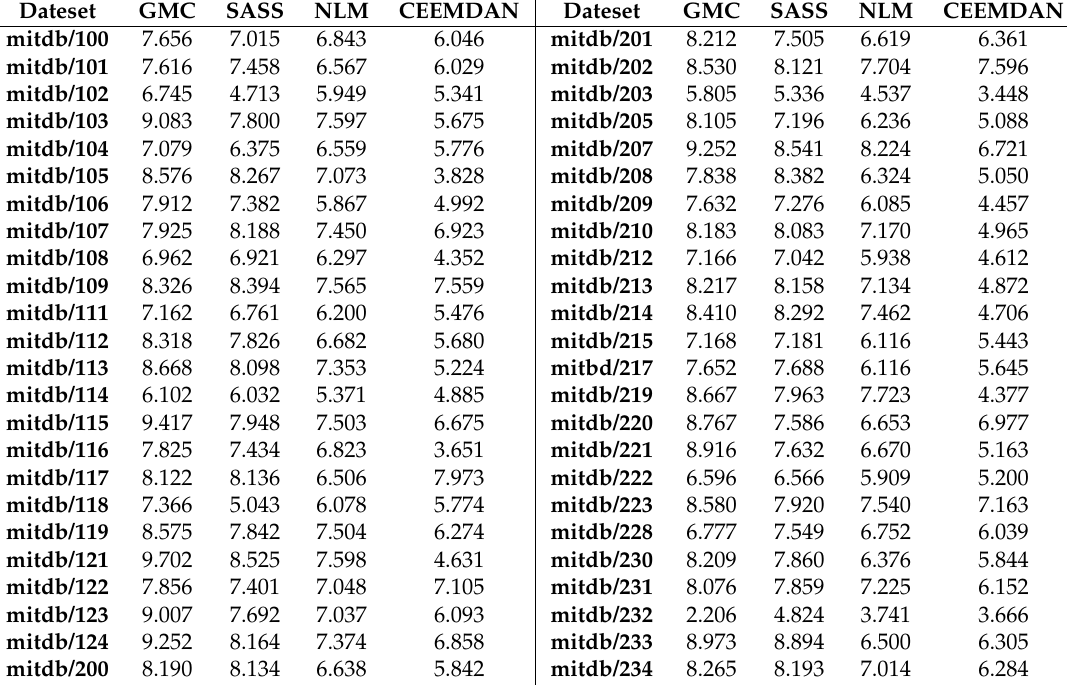
Table 1. Comparison of the SNR imp achieved by different methods with input SNR = 10 dB.